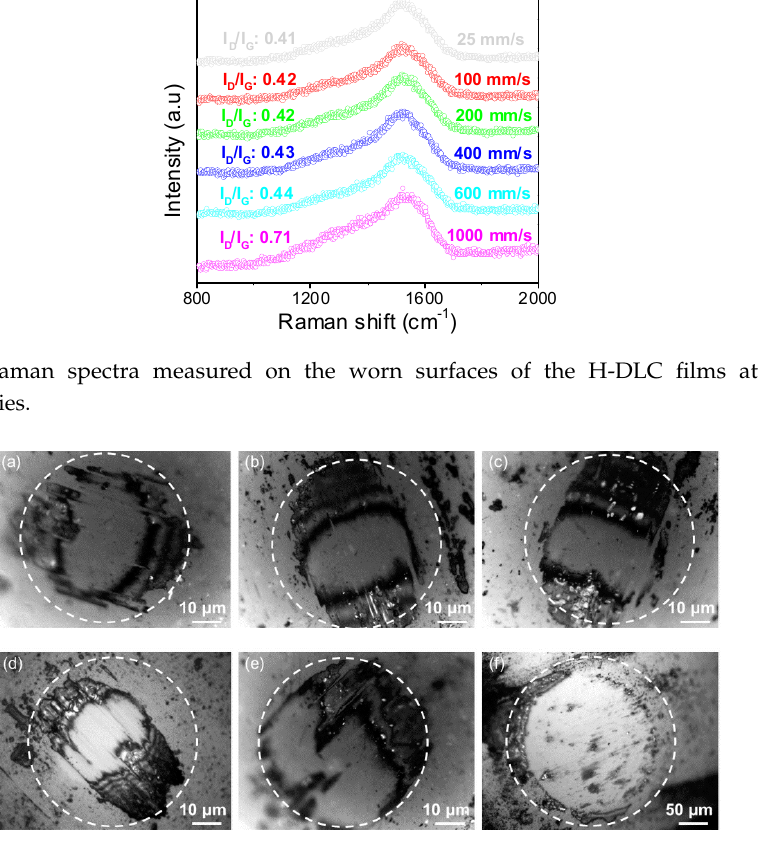
Figure 6. Optical micrographs of the worn surfaces on the Al 2 O 3 balls after sliding against the H ‐ DLC film at various sliding velocities. ( a ) 25, ( b ) 100, ( c ) 200, ( d ) 400, ( e ) 600, and ( f ) 1000 mm/s. Note that the scale at 1000 mm/s in ( f ) is five times larger than that at other conditions. Coatings 2018 , 8 , x FOR PEER REVIEW